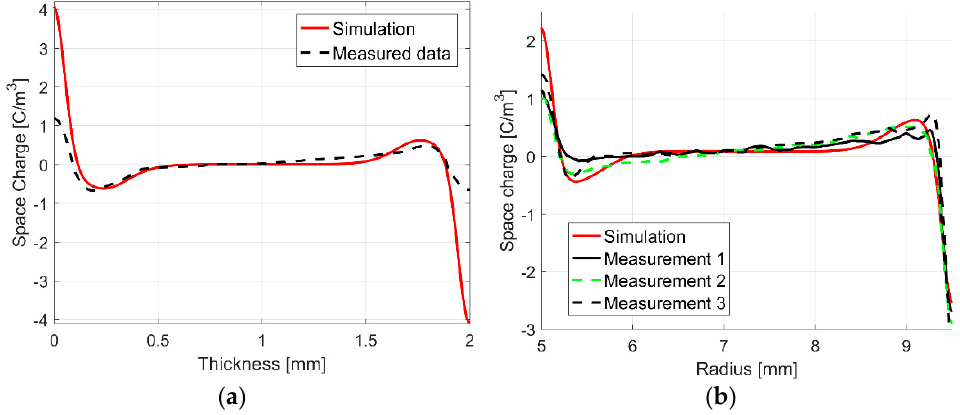
Figure 4. ( a ) Measured and simulated charge distribution in a planplanar cross-linked polyethylene (XLPE) insulation [20]; ( b ) Measured and simulated charge distribution in a cylindrical XLPE insulation [10,19]. In Figure 4b, three different XLPE cable measurements, labeled with numbers “1”–“3”, are seen.